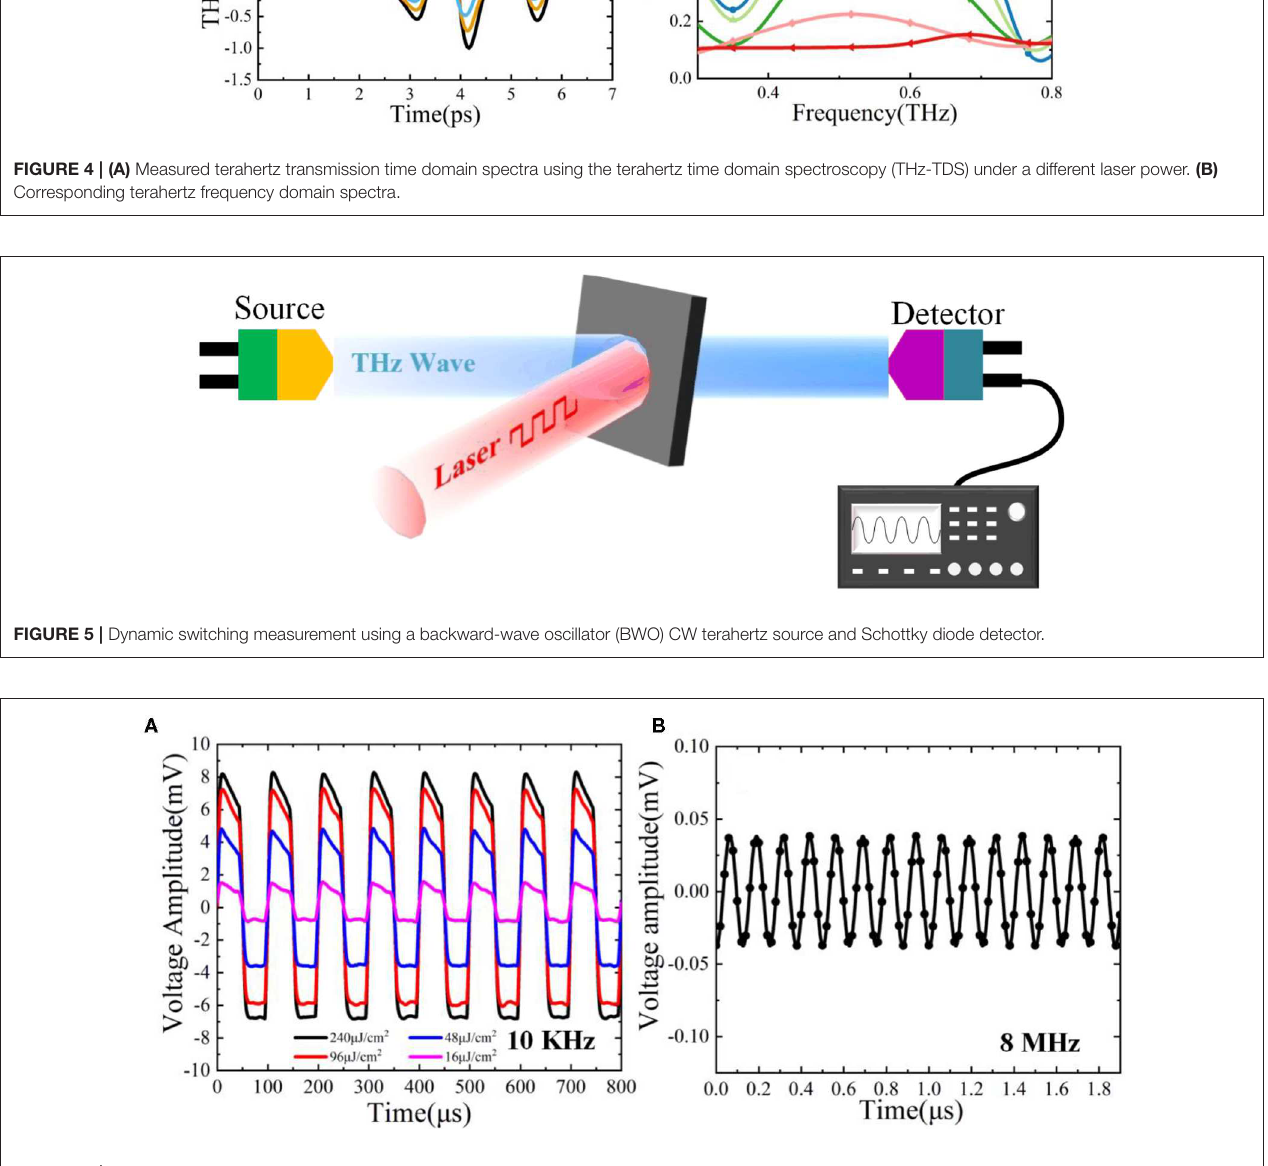
wave transmission intensity drops to 10.9% of its original value under 240 µ J/cm 2 pump laser intensity. As depicted in Figure 7B , the corresponding extinction ratio is 83%. Figure 7C shows the extinction ratio dependence of the pump laser fluence